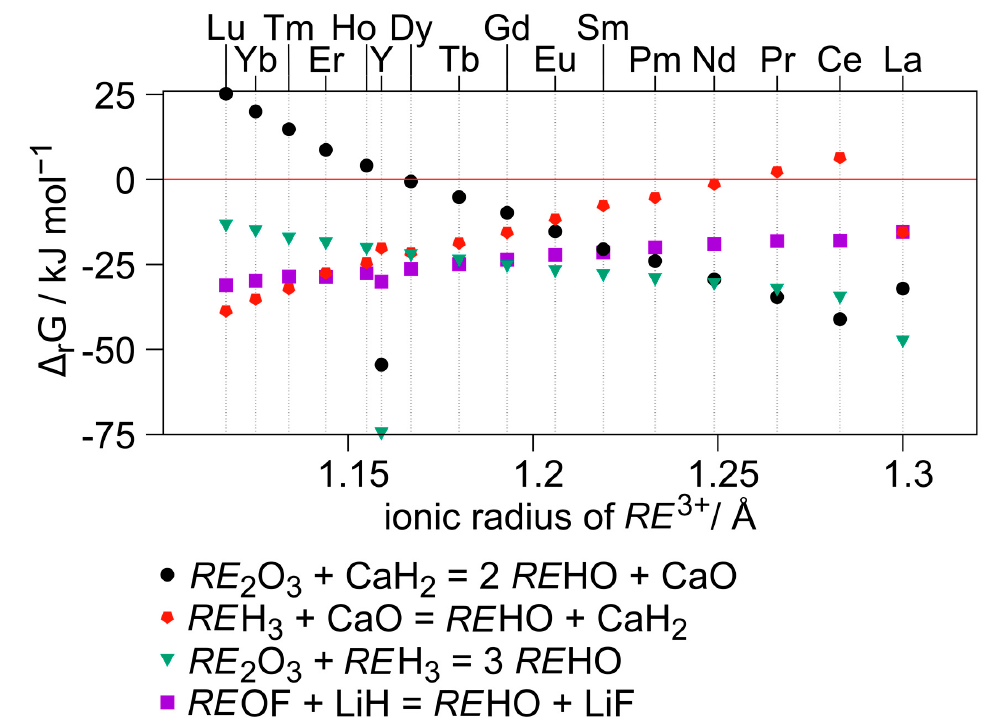
Figure 8. Plot of the free reaction enthalpies ∆ r G for different synthesis approaches against the ionic radii of eightfold coordinated RE 3+ ions